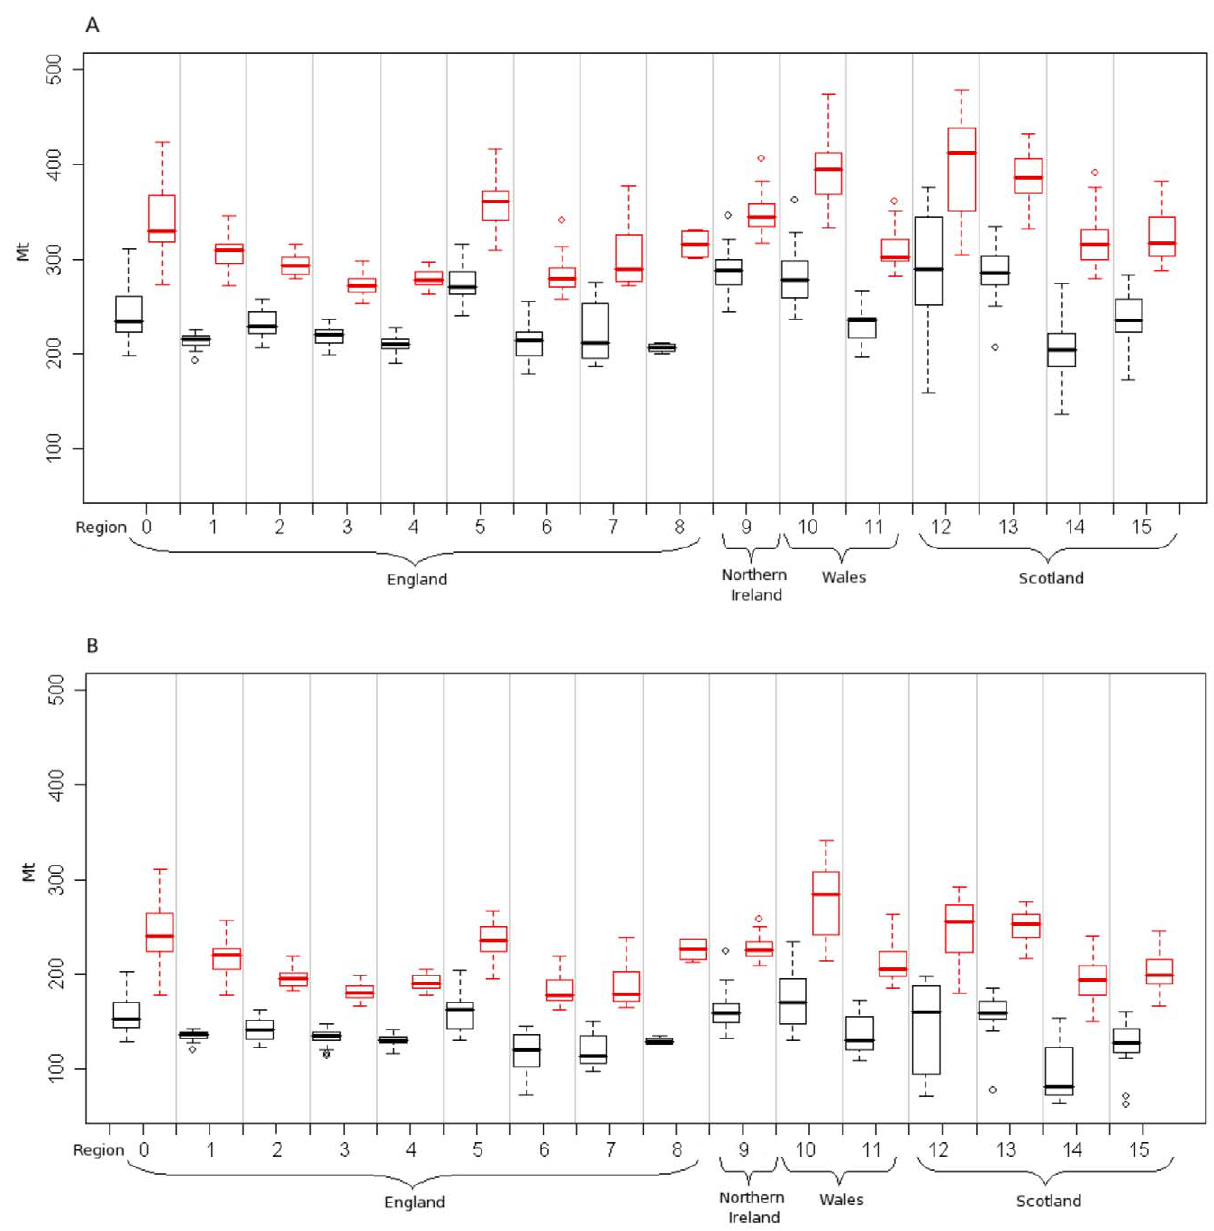
Figure 7. Comparing past and future risk. F. hepatica risk for each region for both 1961–1990 (black) and 2030–2070 (red) long term averages, for a) summer and b) winter. For region codes see Fig.